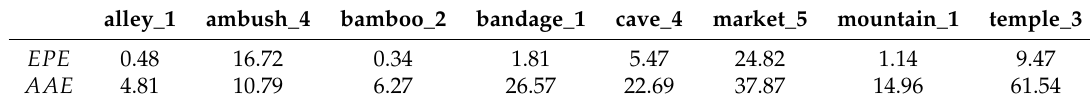
Table 4. Results obtained by PSO in the MPI-Sintel selected training